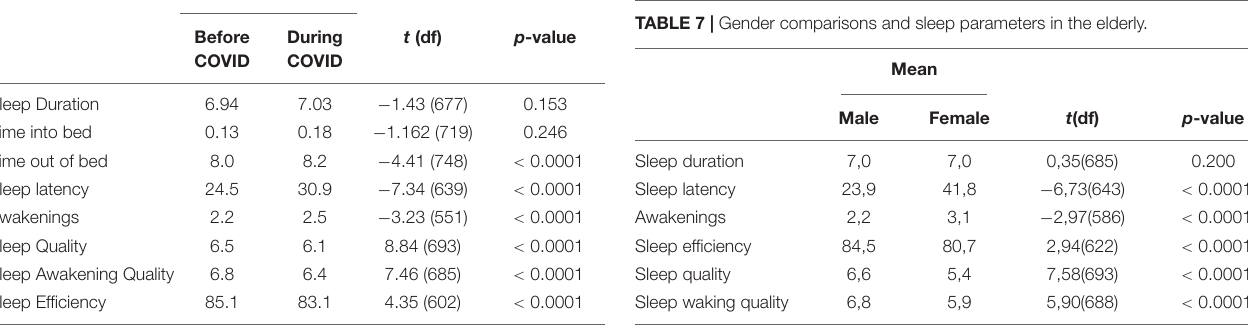
TABLE 7 | Gender comparisons and sleep parameters in the